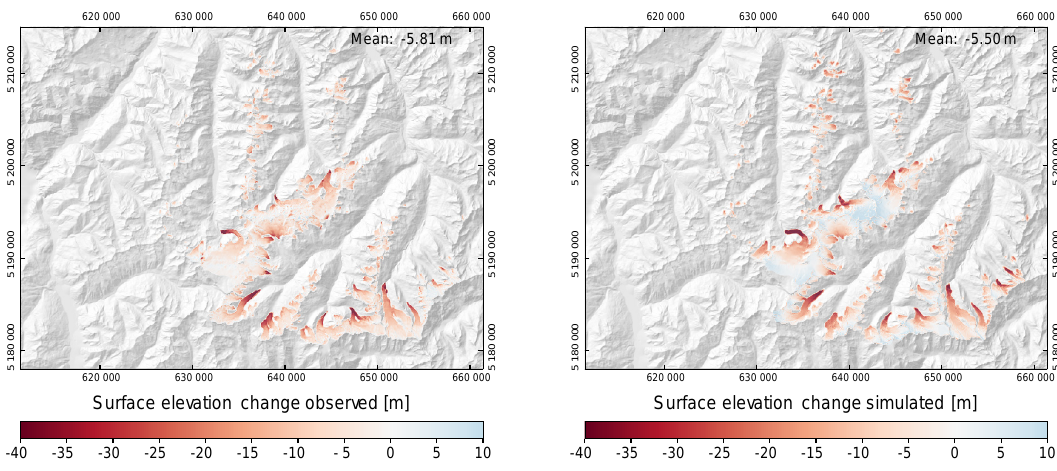
Figure 15. Observed and simulated glacier surface elevation change for the period 1997–2006. Table 6. R 2 , Nash–Sutcliffe efficiency (NSE), and percent bias (PBIAS) for observed vs. simulated snow depth obtained using uncorrected and corrected precipitation, respectively.